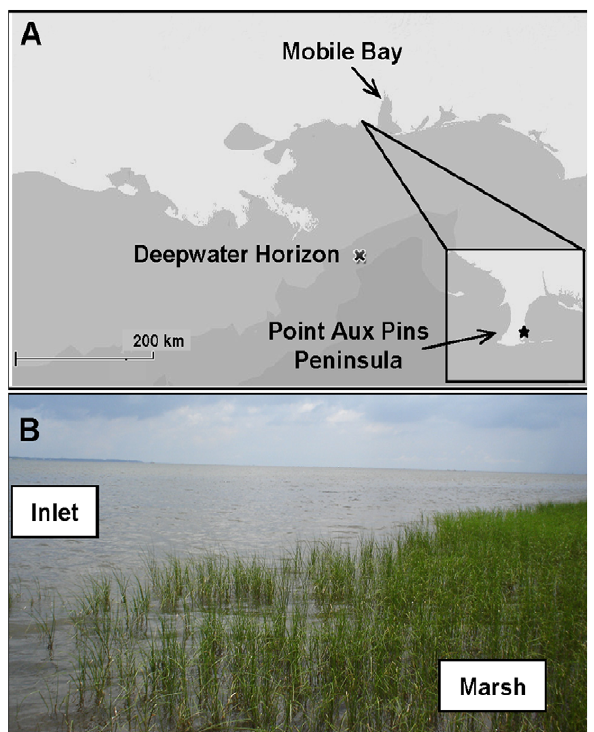
Figure 1. Study site. (A) Map of Point Aux Pins peninsula. Study site indicated by box in inset. (B) Sediment samples collected , 25 m from shore outside the marsh stands (designated ‘‘Inlet’’) and 2–4 m from shore within the marsh stands (designated ‘‘Marsh’’).